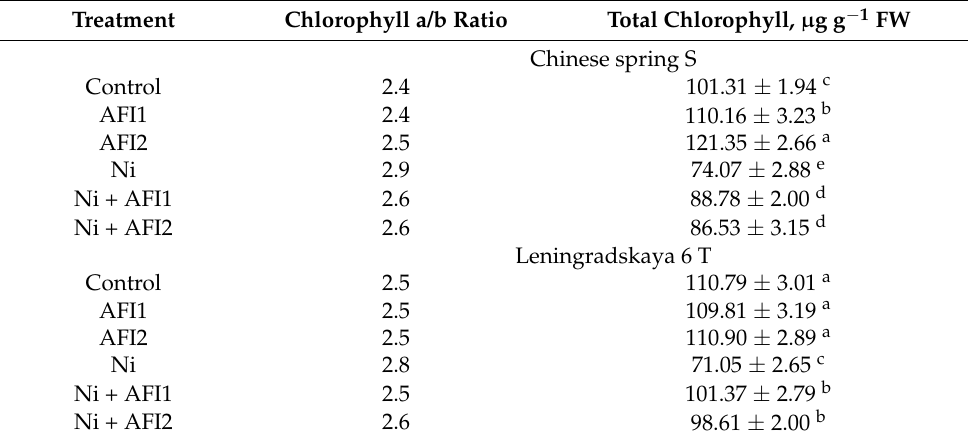
Table 3. Effects of PGPB Bacillus megaterium AFI1 and Paenibacillus nicotianae AFI2 on total chlorophyll content and chlorophyll ratio in wheat plants under Ni stress. Treatment Chlorophyll a/b